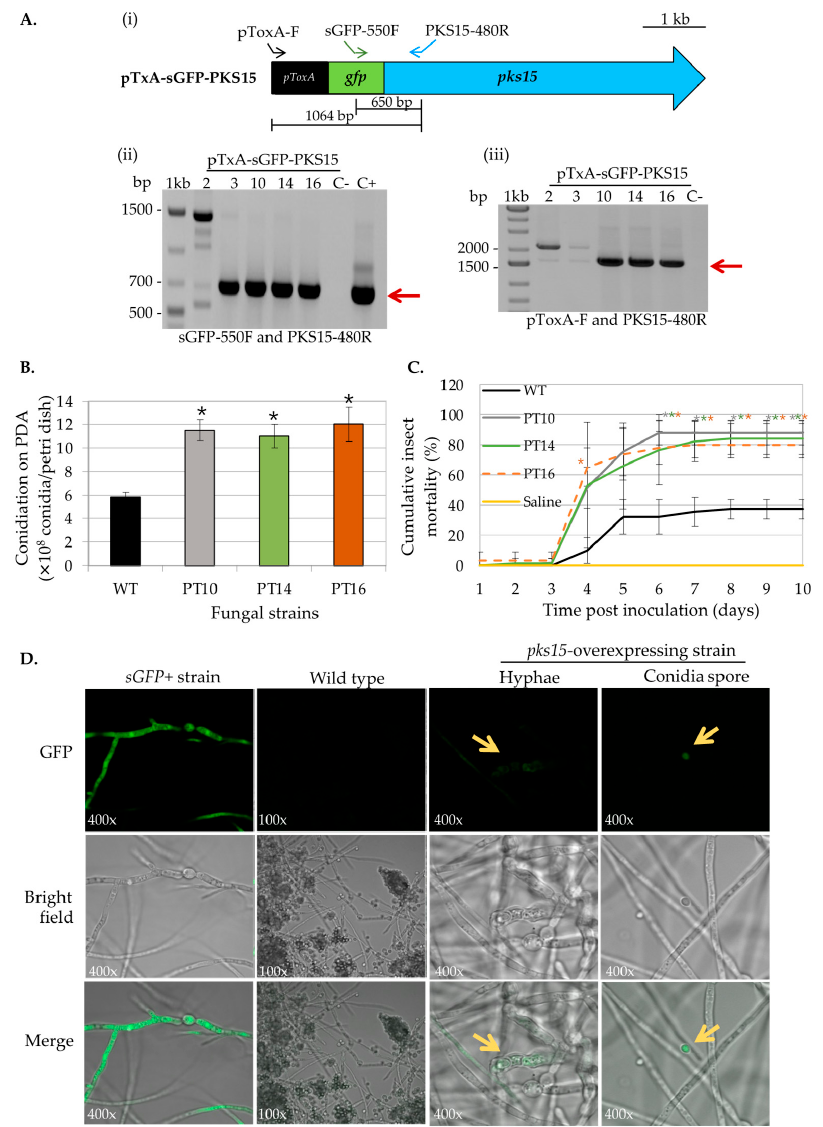
Figure 2. Phenotype characterization of OE pks15 strains. ( A ) Ectopic integration of the pks15- overexpression cassette was verified by PCR with specific primers ( i ). The OE pks15 strains 10, 14, and 16 showed the expected bands at 650 bp (red arrow) using primers sGFP-550F and PKS15-480R, specific for sGFP and pks15 , respectively ( ii ), and 1604 bp (red arrow) using primers pToxA-F and PKS15-480R, specific for the ToxA promoter and pks15 , respectively ( iii ). B. bassiana BCC2660 genomic DNA and the vector pTxA-sGFP-PKS15 were used as negative (C − ) and positive (C+) controls, respectively. ( B ) Conidiation and ( C ) insect mortality were increased in OE pks15 strains 10, 14, and 16. ( D ) Subcellular localization of the PKS15 in Oe pks15 strain 16 exhibited the unique pattern of green fluorescence (GFP) in pseudohyphae-like cells and conidia (yellow arrow) compared to the negative control, B. bassiana wild type, and the positive control, the B. bassiana sGFP+ strain (sGFP alone and having GFP fluorescence homogenously in the cytoplasm). Asterisks indicate statistical significance ( t -test, p <